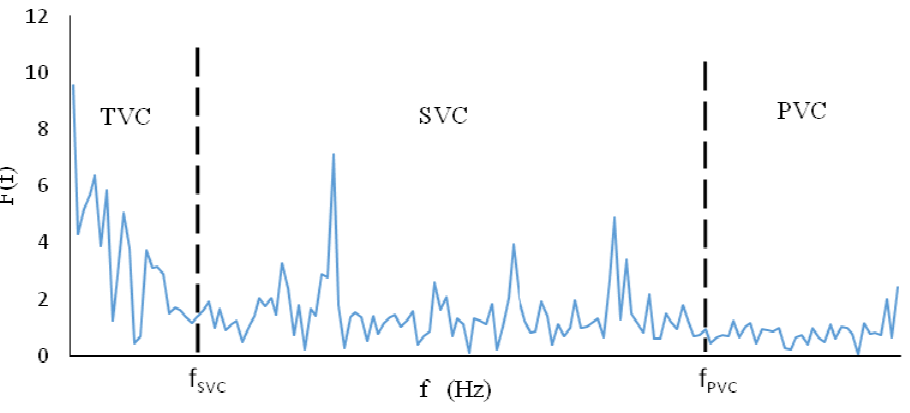
Figure 1. Hierarchical structure of an AVC in the frequency